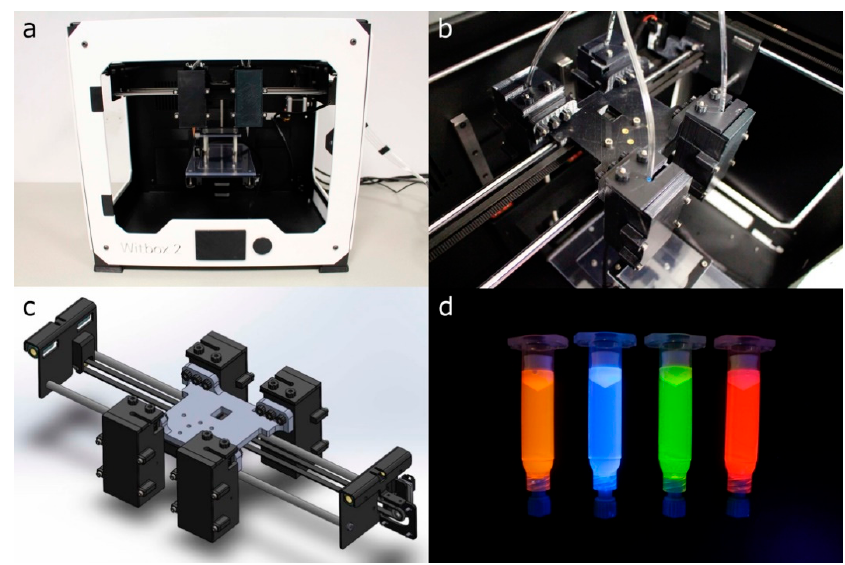
Figure 2. ( a , b ) general and detailed view of the modified Witbox 2 3D printer with four bioprinting printheads; ( c ) 3D CAD design of the 3D printer x -carriage; ( d ) 5 mL syringe barrels loaded with dyed P407 hydrogels.